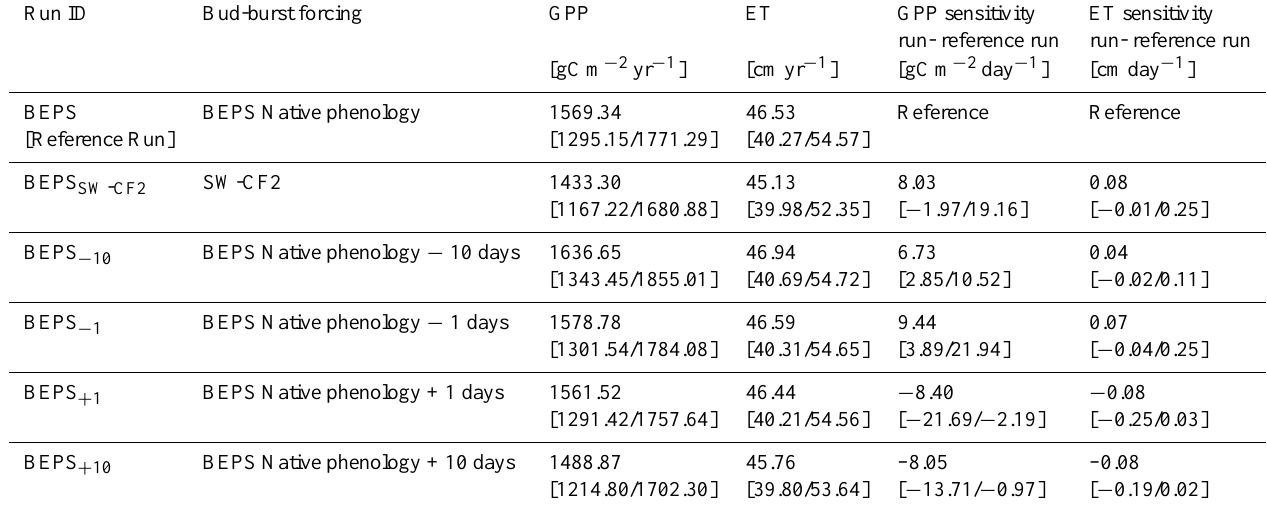
Table 4. Summary of BEPS simulation protocol. Bud-burst forcing represents the bud-burst dates used for model runs. GPP is the mean Gross Primary Productivity, ET is the mean evapotranspiration while GPP and ET sensitivity represent the average difference to the reference run for annual GPP and annual ET expressed as variations of gCm − 2 and cm of water per 1 day of variation of bud-burst. The reference run is the run conducted with BEPS and with bud-burst simulated with its internal phenological routine. In squared parentheses the minimum and maximum values for each variable are